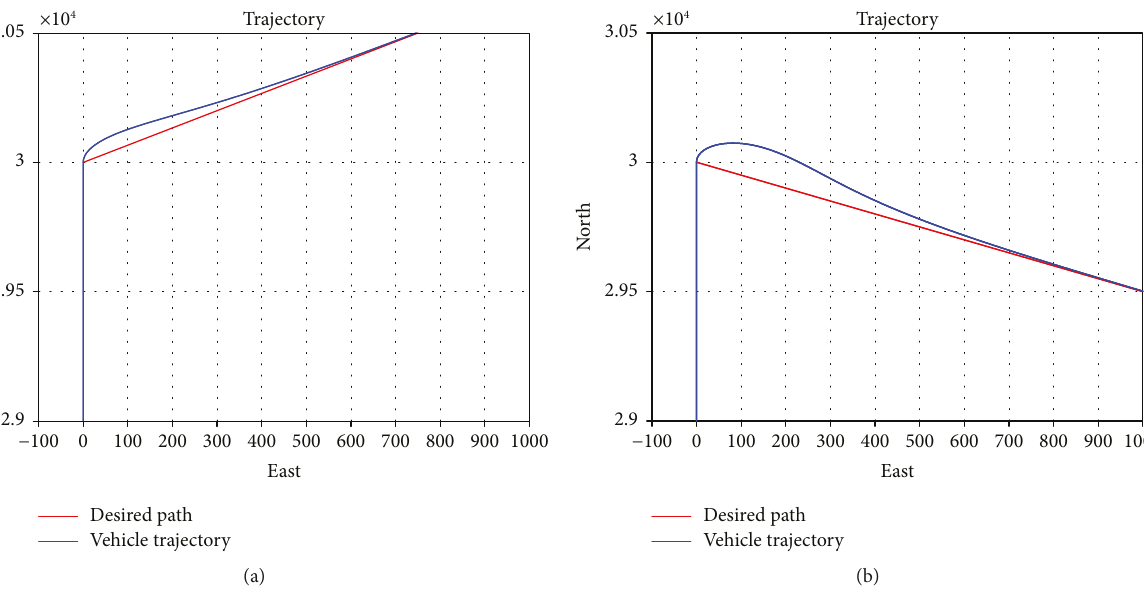
Figure 11: Path transition over the waypoint. (a) Obtuse angle, (b) acute angle. Table 1: Initial conditions used in